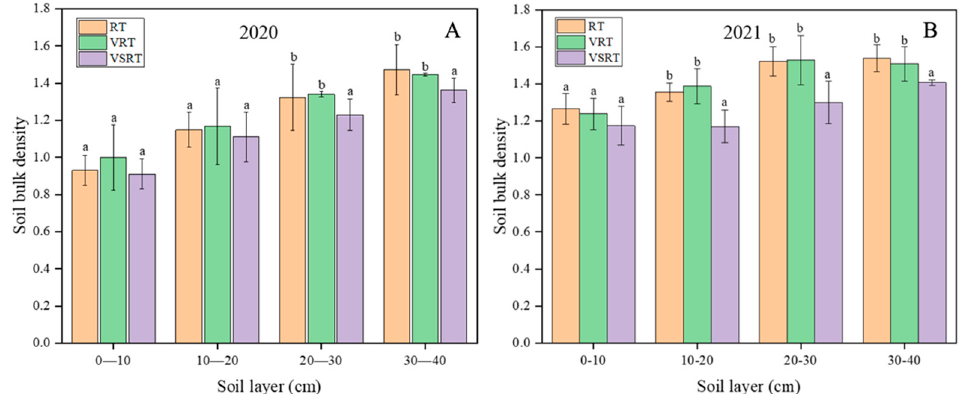
Figure 5. Soil bulk density of the 0—40 cm soil layer under three the tillage methods. ( A ): The soil bulk density in 2020; ( B ): The soil bulk density in 2021. Different lowercase letters in the same soil layer indicate significant differences at a p < 0.05 level. Rotary tillage, RT; vertical rotary tillage, VRT; vertical smashing rotary tillage, VSRT.